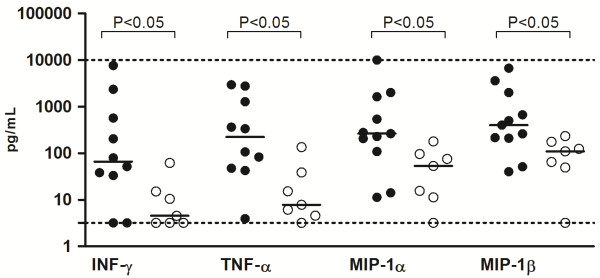
Comparison of cytokine levels in patients with LP performed after 48 h (>48 h) from initial symptoms. S. pneumoniae patients showed higher levels of IFN-γ, TNF-α, MIP-1α e MIP-1β compared to N. meningitidis patients (P < 0.05 by Mann Whitney test). Dotted lines mark the upper and lower limits of detection.